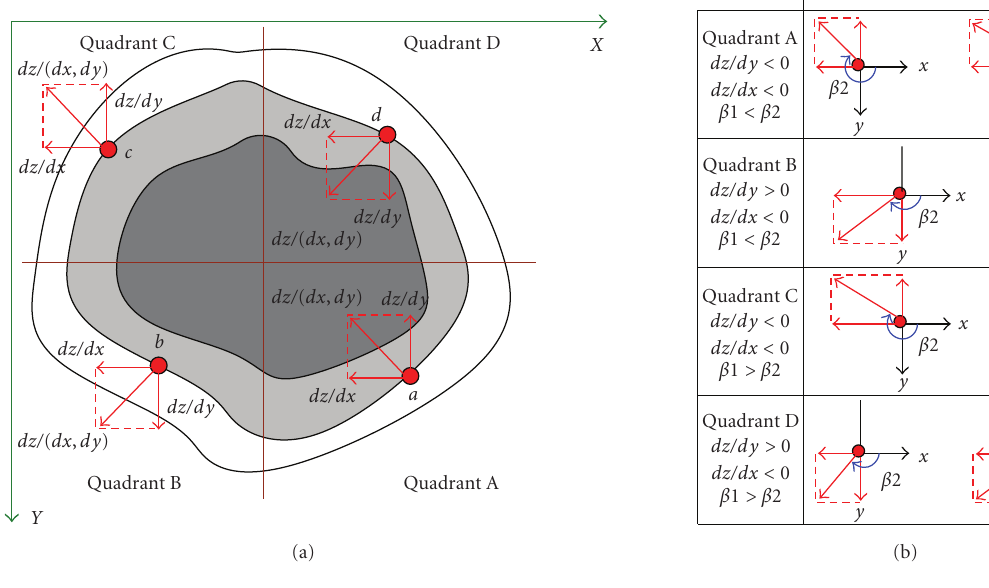
Figure 7: Detection of the quadrant voting across the X axis. Table 1: Precision and recall for di ff erent radii on two images: one pixel corresponds to 0.01 millimeter. First image